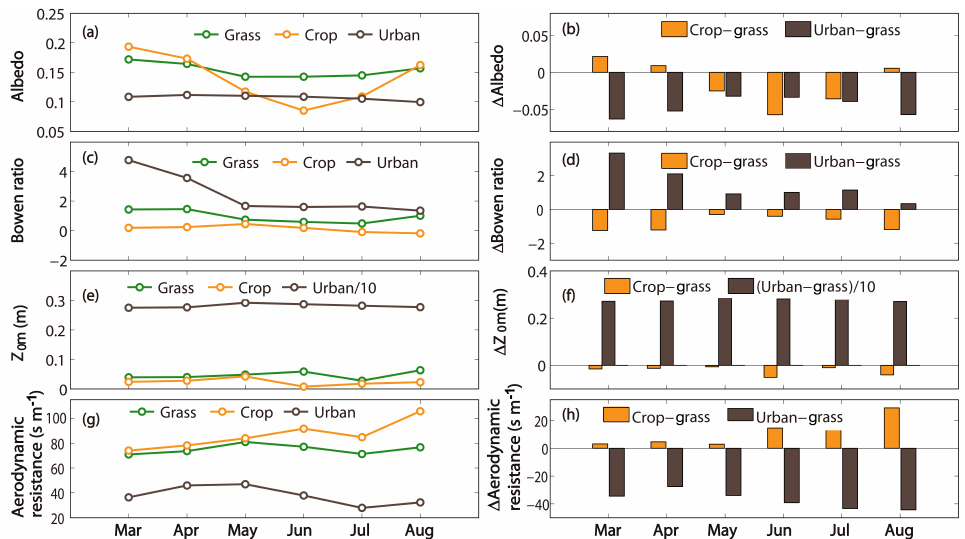
Figure 2. Monthly variations of different factors at the three sites and the differences between the other two sites and the grass site in Nanjing from March to August 2013: (a, b) albedo, (c, d) the Bowen ratio, (e, f) surface roughness, and (g, h) aerodynamic